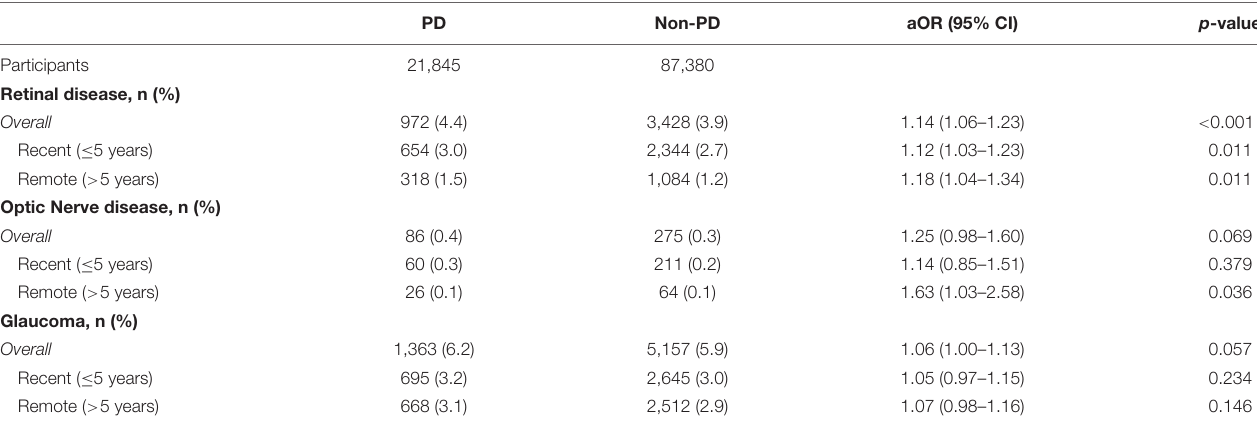
TABLE 2 | The aOR of retinal disease, optic nerve disease and glaucoma among the study participants in the case–control study. PD Non-PD aOR (95% CI) p -value